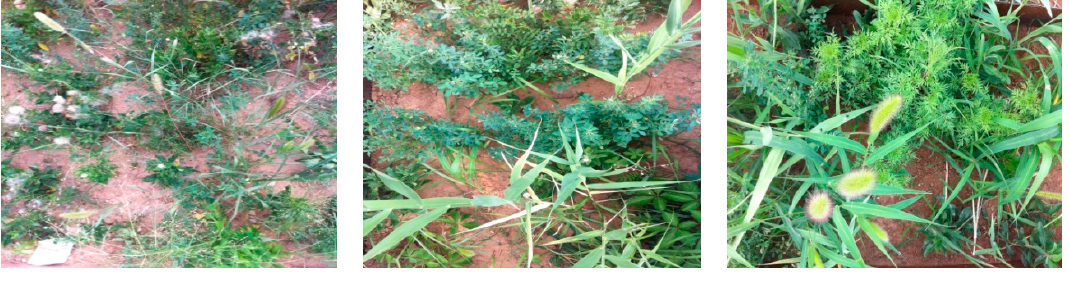
Figure 4. Growth of herbaceous plants on the slope.